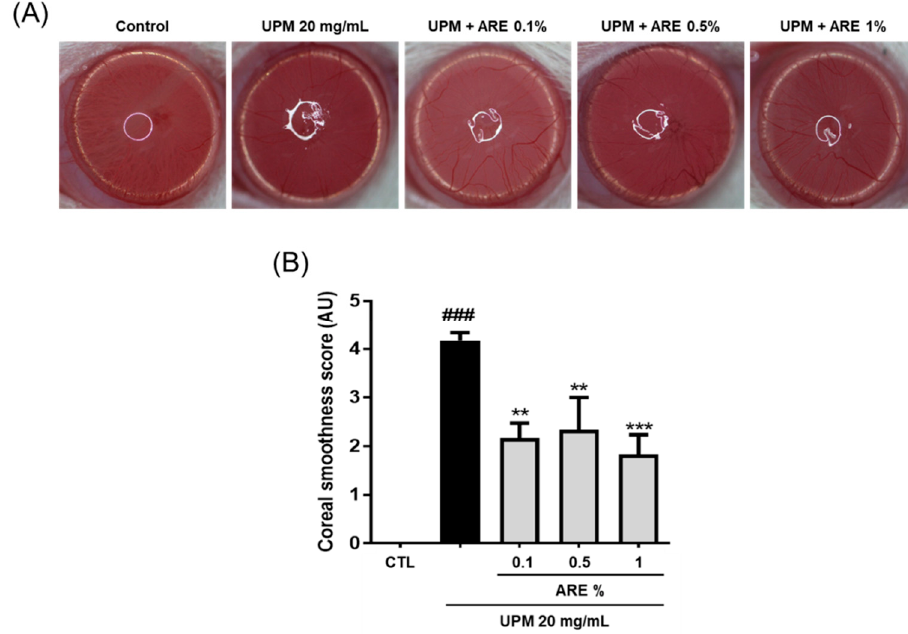
Figure 3. Achyranthis radix extract improved corneal smoothness. ( A ) Corneal smoothness was evaluated by the reflection images of the white ring from the light source on the surface of the eye. ( B ) Each bar represents mean corneal irregularity score ± SEM, n = 6. ### p < 0.001 vs. control group, ** p < 0. 01, *** p < 0.001 vs. urban particulate matter group. ARE, Achyranthis radix extract; UPM, urban particulate matter; CTL, control; AU, arbitrary